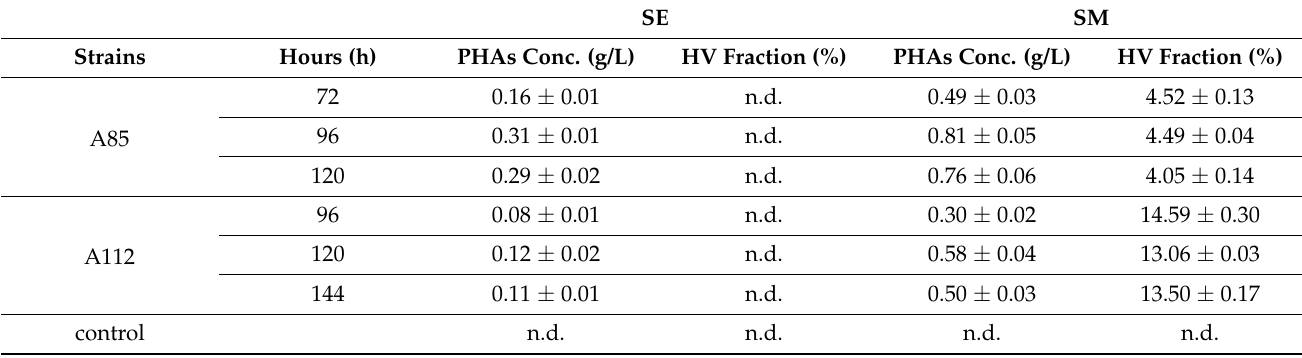
Figure 4. Gas chromatography analysis of PHAs obtained from different cultures of the isolates grown in the unsterilized SE and SM mediums. ( A ) Strain A85 in the SE medium, ( B ) strain A85 in the SM medium, ( C ) strain A112 in the SE medium, ( D ) strain A112 in the SM medium, ( E ) positive control, PHBV standard (Sigma Aldrich Catalog No: 403121, 12 mol % PHV content), and ( F ) negative control, the SE medium without seed culture inoculation. The peaks at 3.2 min and at 3.75 min represent the 3-hydroxybutyrate (3-HB) methyl ester and 3-hydroxyvalerate (3-HV) methyl ester, respectively. Table 4. The PHA accumulation in open